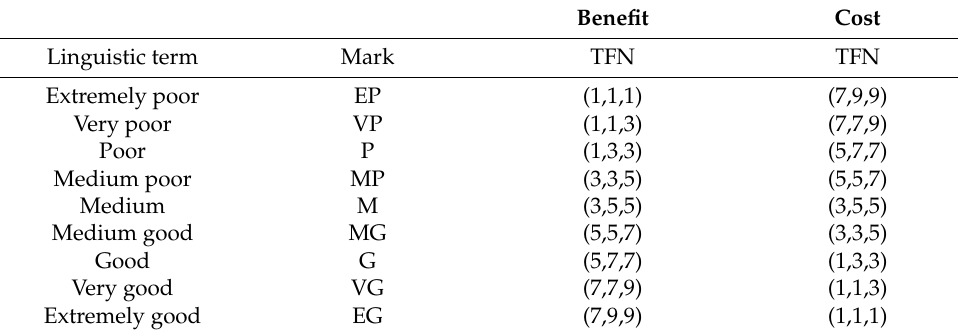
Table 9. Fuzzy linguistic scale for evaluating alternatives